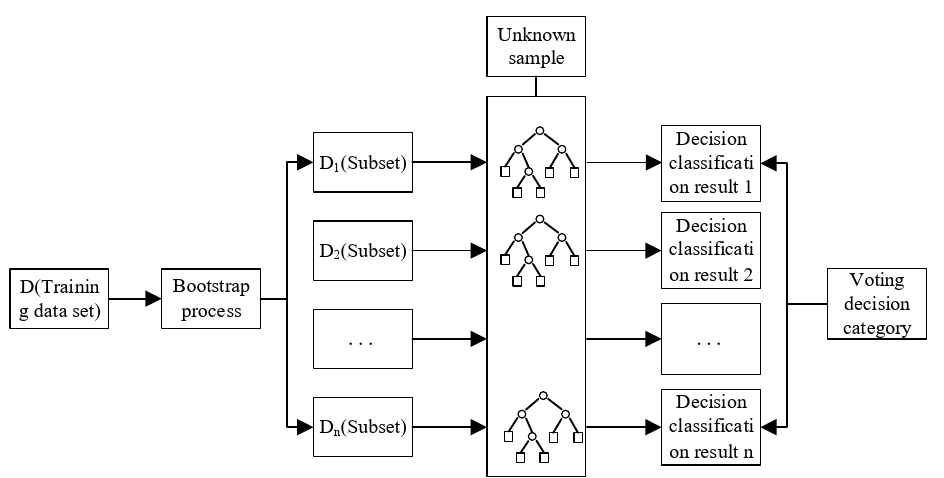
Figure 9. A flow chart of the random forest classification process. The tree established by each subset divides the nodes with optimal features. As the partitioning process continues, the samples contained in the branch nodes of the decision tree belong to the same category as much as possible, i.e., the “purity” of the nodes increases. The information gained indicates improvement in the degree of purity of the fea- ture.